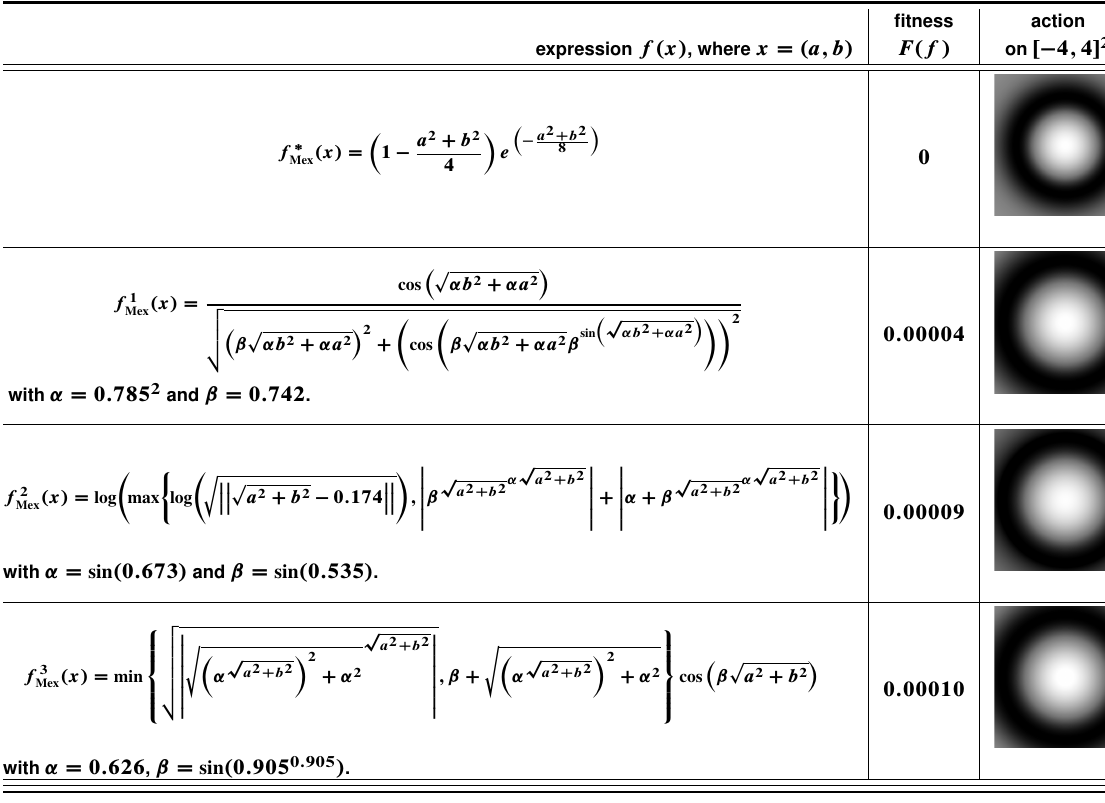
Table 3. The three best solutions on a run of the MexHat problem using the G long function set.